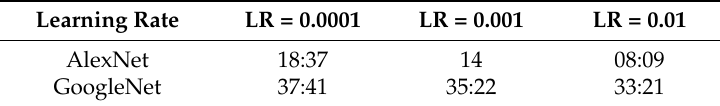
Table 3. Runtime costs for the learning process of the CNNs (in minutes). Learning